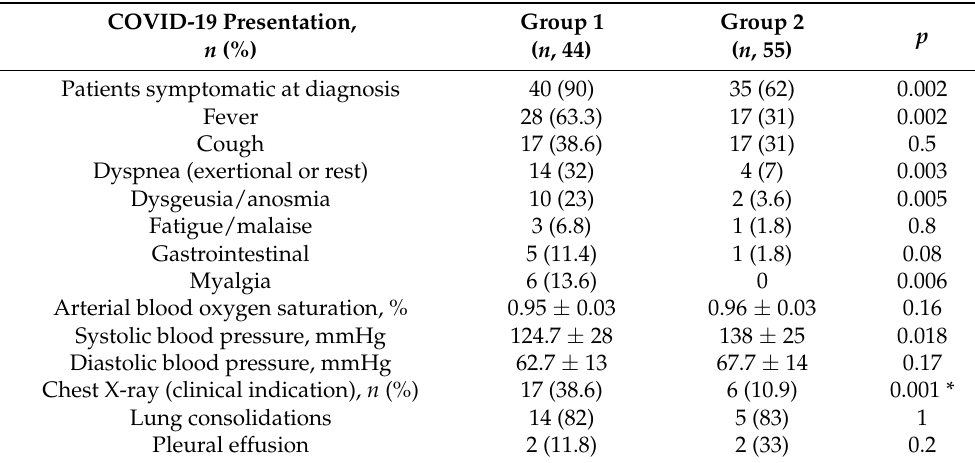
Table 2. Clinical presentation and basal radiological findings of hemodialysis patients affected by COVID-19 during the different periods